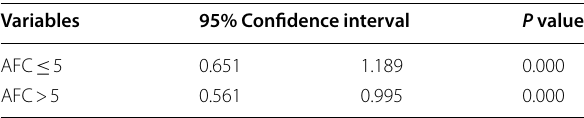
Table 5 Multiple linear regression analysis among number of metaphase II (MII) oocytes retrieved and related